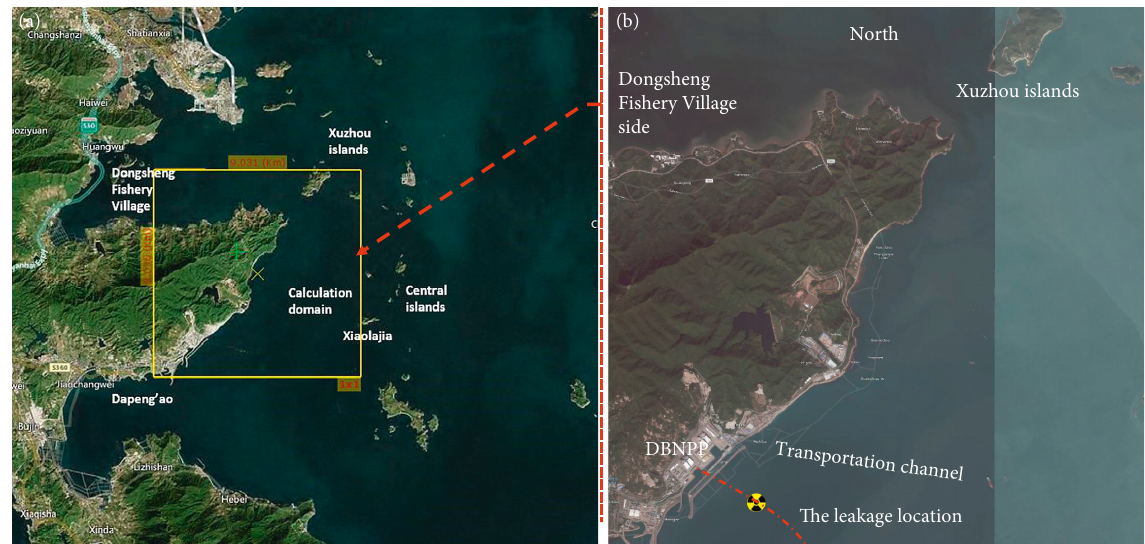
Figure 2: Accident scenario of marine transportation in DBA. (a) Real terrain. (b) Terrain model.